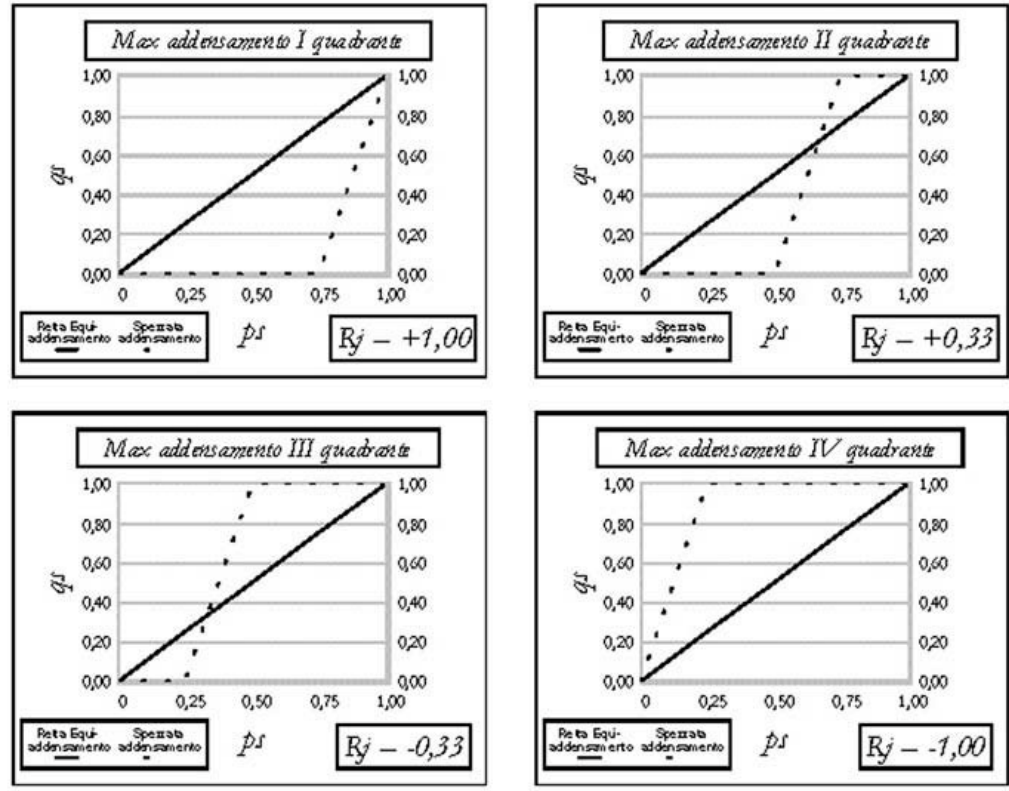
Figura 3 – Rappresentazione grafica delle ipotesi estreme di addensamento degli item nei quattro